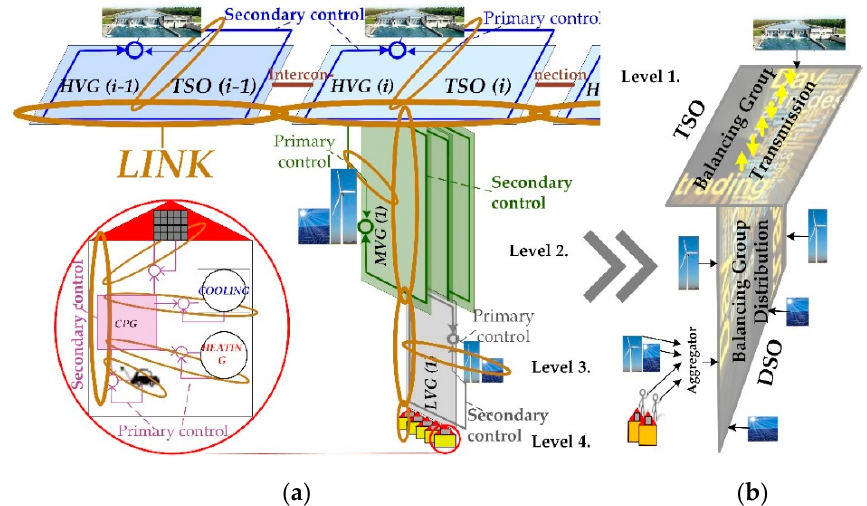
Figure 13. Overview of the holistic models: ( a ) Technical, the “energy supply chain net”; ( b ) market.